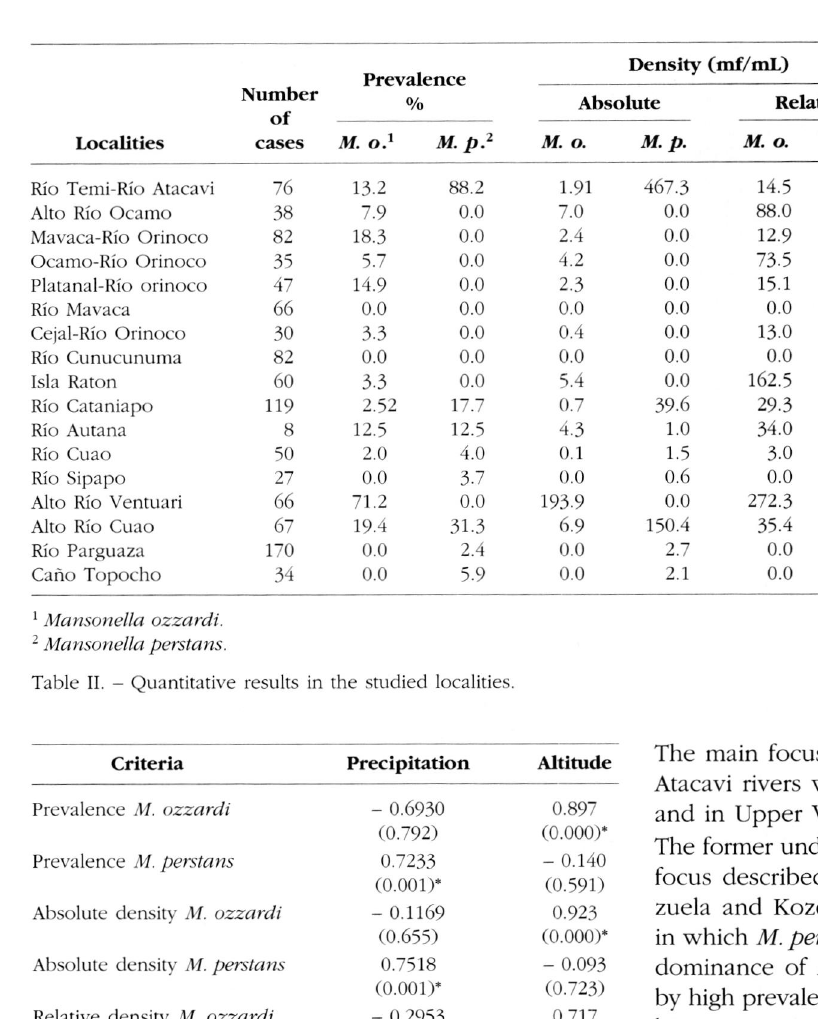
Table III. - Pearson's correlation coefficients between quantitative criteria and environmental variables.